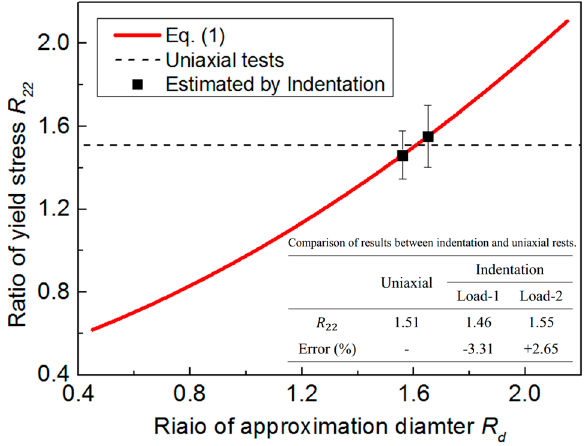
Figure 13. Out-of-plane deformation contour: ( a ) The prescribed indentation load is 400 N; ( b ) The prescribed indentation load is 500 N.